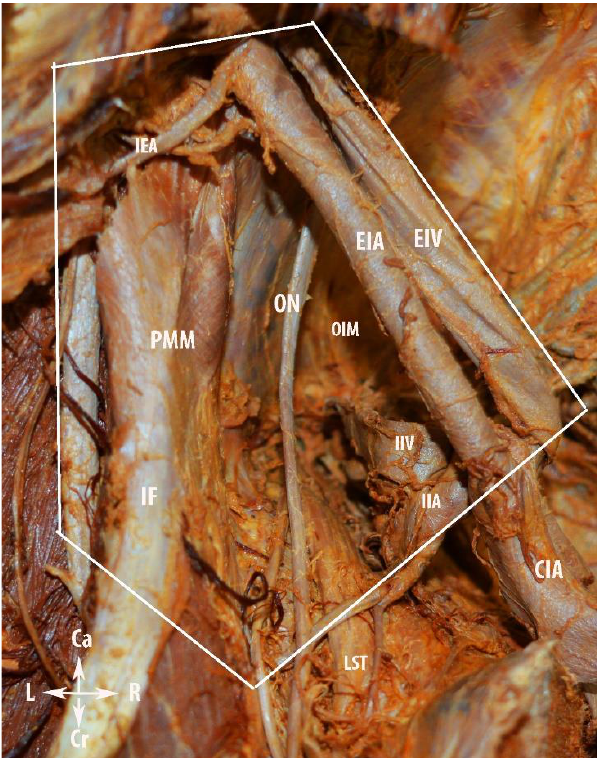
Figure 4. Limits of the avascular region of the pelvic sidewall. IEA — inferior epigastric artery; PMM — psoas major muscle; ON — obturator nerve; OIM — obturator internus muscle, LST — lumbosacral trunk; CIA — common iliac artery; IIA — internal iliac artery; IIV — internal iliac vein; EIA — external iliac artery; EIV — external iliac vein; IF — iliacus fascia covering the psoas major muscle; Ca — caudal; Cr — cranial; R — right; and L — left.